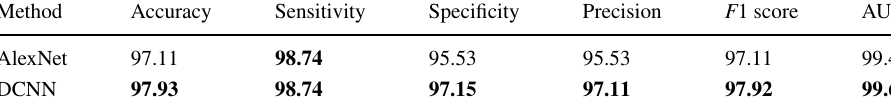
The values indicated in bold in the columns represent the highest